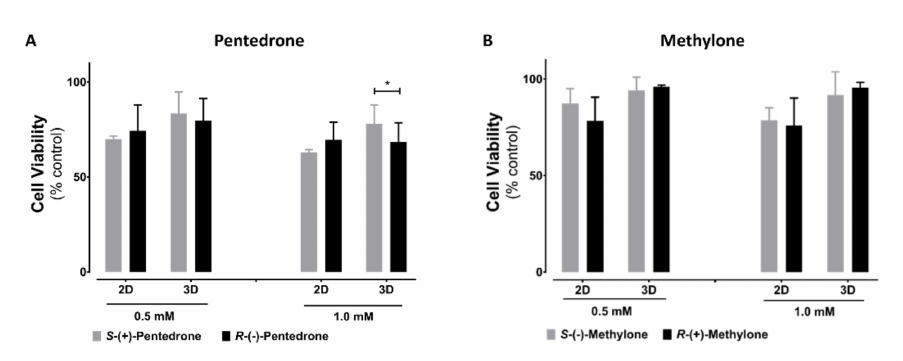
Figure 5. Cytotoxicity in HLCs exposed to 0.5 and 1.0 mM of ( A ) pentedrone and ( B ) methylone enantiomers evaluated by CellTiter-Glo ® , after 24 h. Data are presented as average ± SD ( n = 3). * p < 0.05.